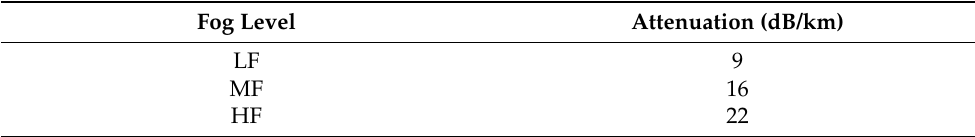
Table 2. Fog level with attenuation [39].